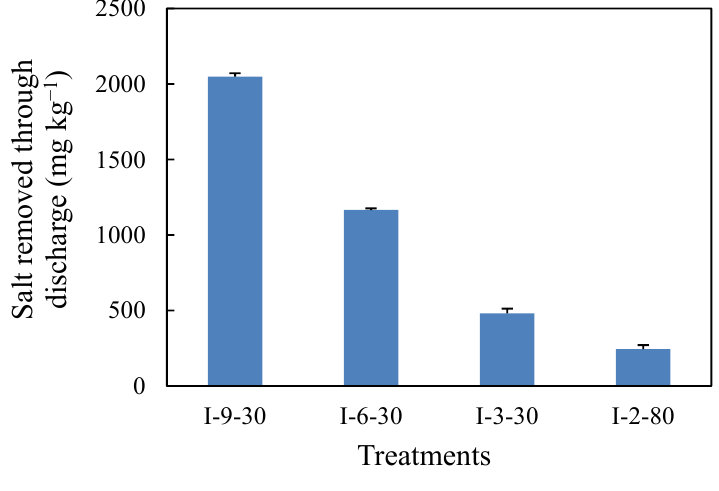
Figure 4. Salt removal by flood water discharge (mg kg − 1 ). The error bars represent the standard